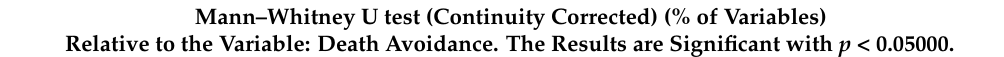
Table 4. The results of the Mann–Whitney U test for variables: FD and AD.